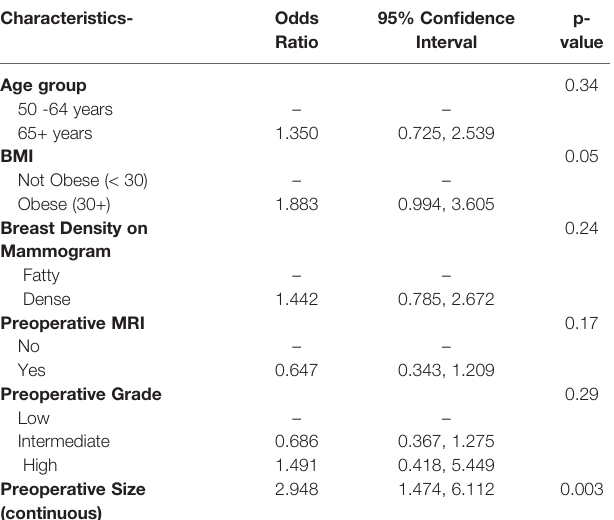
TABLE 4 | Multivariate analysis of predictors of suitability group change.